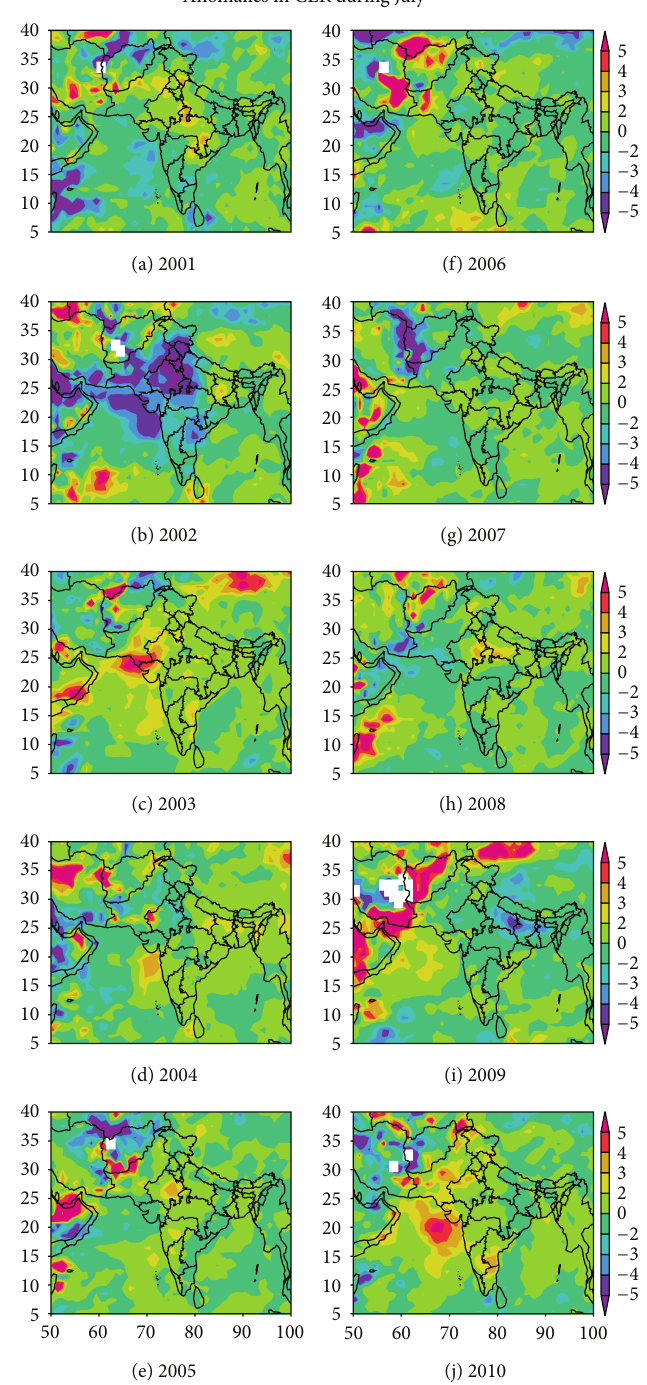
Figure 11: Anomalies in cloud effective radius (CER, 𝜇 m) over the Arabian Sea, India, and the Bay of Bengal during July in (a) 2001, (b) 2002, (c) 2003, (d) 2004, (e) 2005, (f) 2006, (g) 2007, (h) 2008, (i) 2009, and (j) 2010.